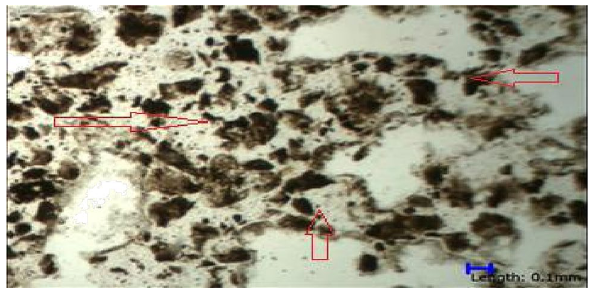
Fig. 7 Sorting and cement development as seen under petrographic microscope for Well Z at a depth of 54–57 m